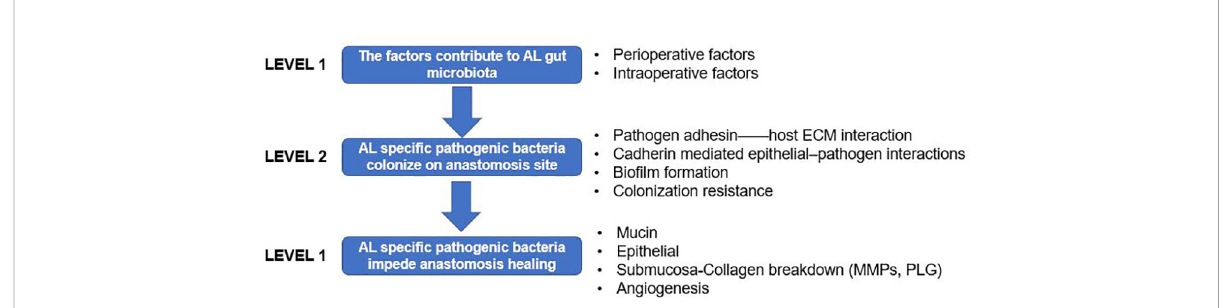
FIGURE 1 Framework of the gut microbiota and anastomotic leak (AL) presented in three levels. Level 1 : factors that contribute to the gut microbiota; level 2 : how pathogenic or collagenase bacteria adhere to the intestinal mucosa and avoid host clearance; and level 3 ; the mechanism by which AL- related gut bacteria interact with the host intestinal epithelial and mesenchymal cells, then affecting anastomotic